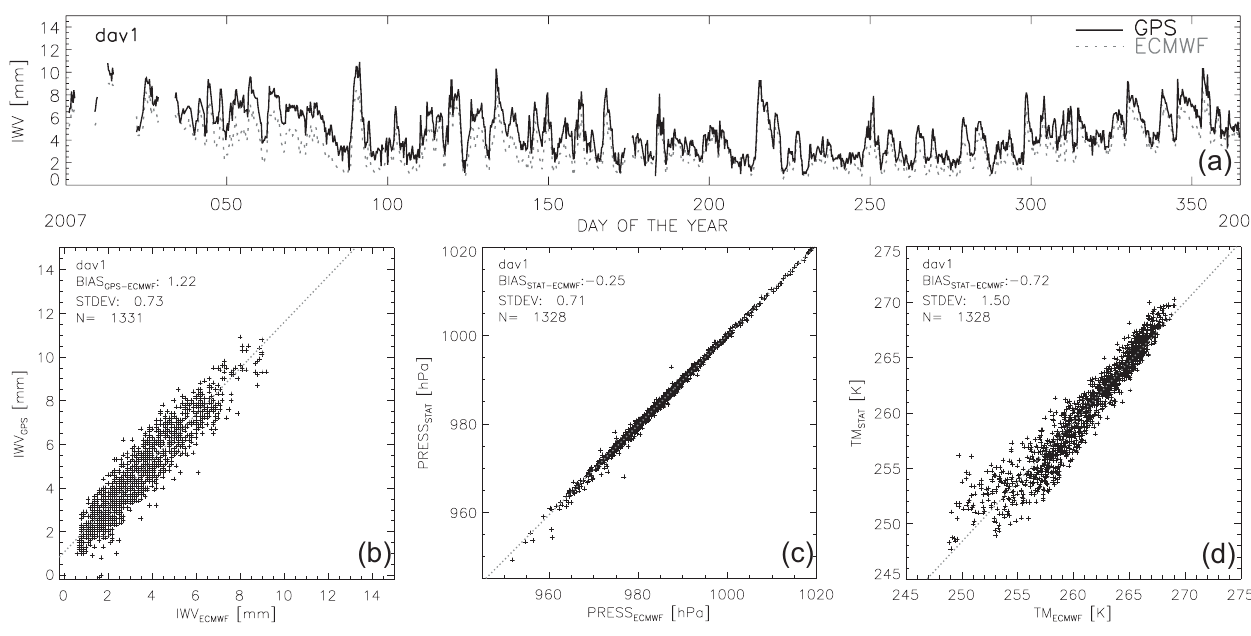
Fig. 3. Same as Fig. 1 but for station